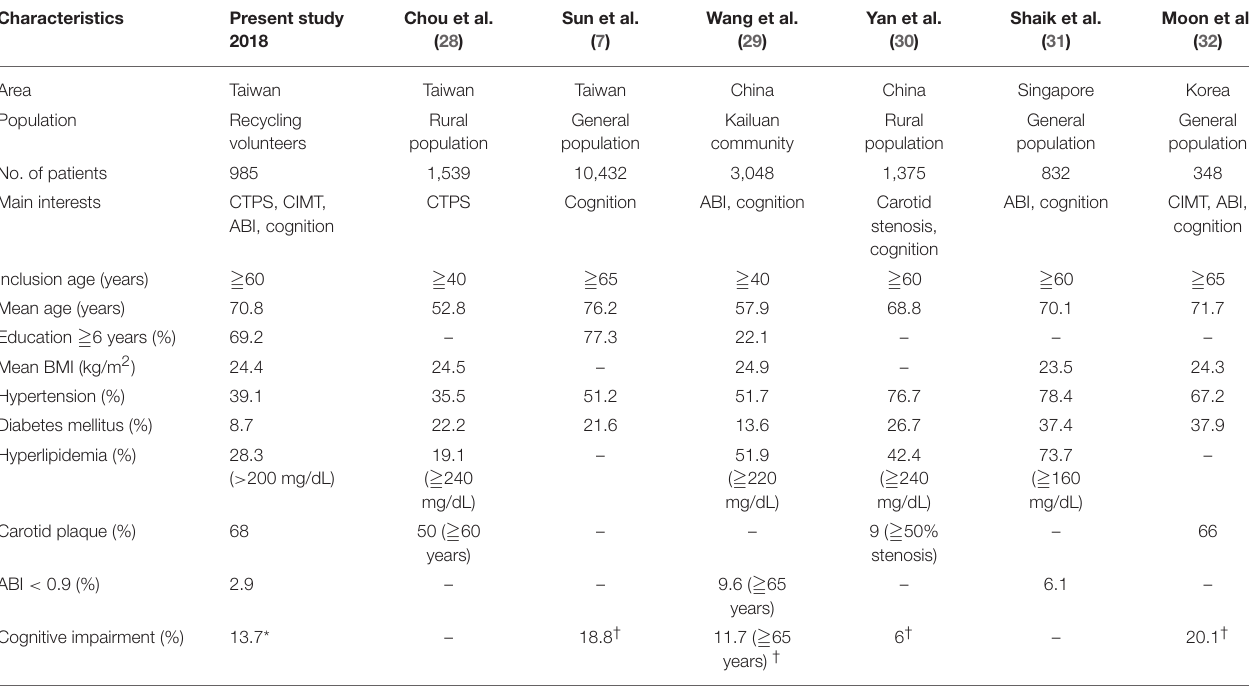
TABLE 8 | Summary of population-based vascular and cognitive survey studies in different Asian areas.